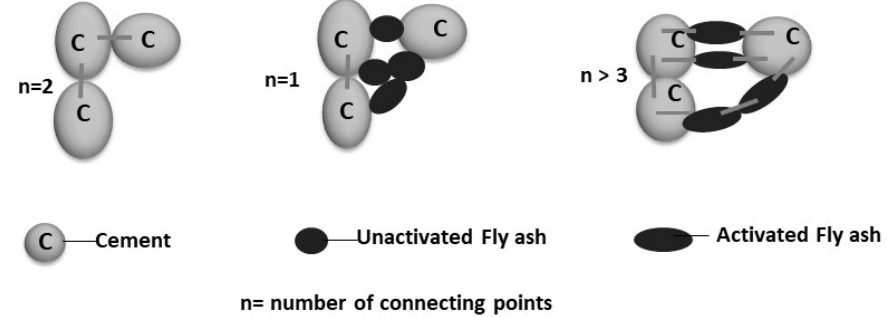
Figure 3. Binding mechanism of activated and inactivated fly ash.